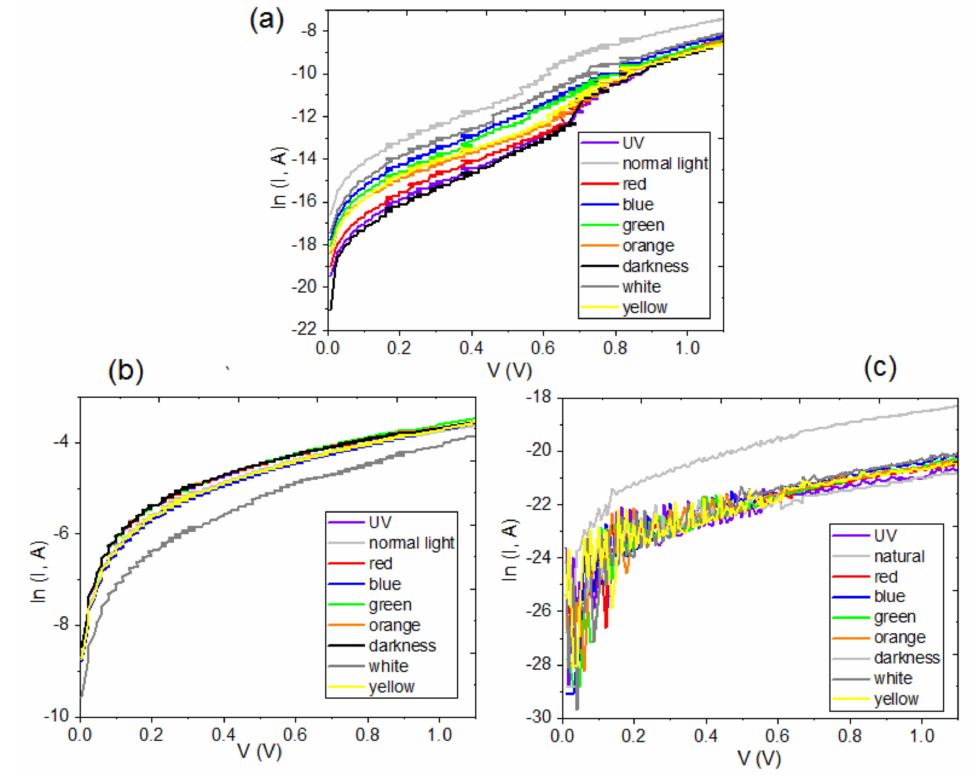
Figure 10. Ln I-V characteristics of ( a ) ITO/PEDOT:PSS/MP/Ag,( b ) ITO/PEDOT:PSS/MP/graphene/Ag and ( c ) ITO/PEDOT:PSS/MP/MoO 3 /Ag